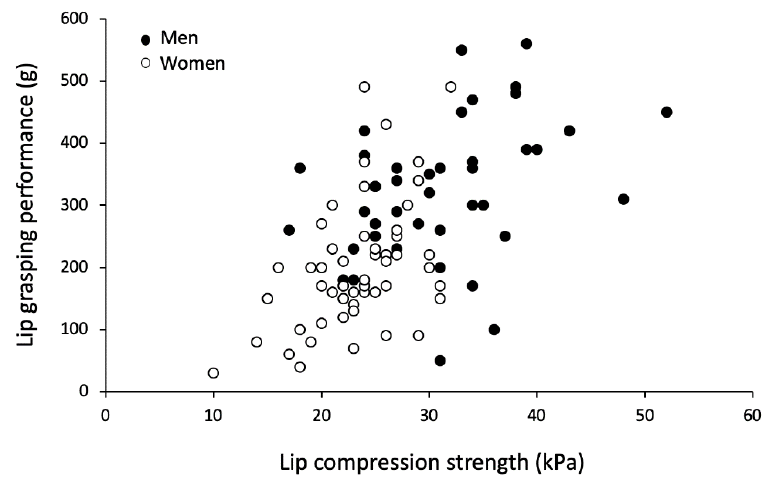
Figure 2. Relationship between lip compression strength (standard method) and lip grasping performance (practical method) in women and men.